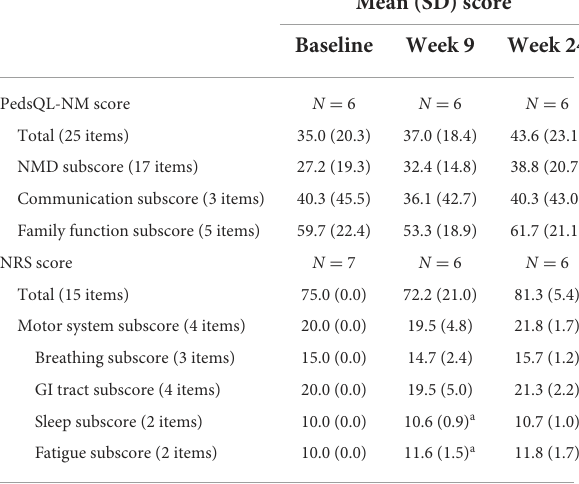
TABLE 4 Quality of life measured using the Pediatric Quality of Life inventory for patients with neuromuscular disease (PedsQL-NM) and symptom severity measured using a numerical rating scale